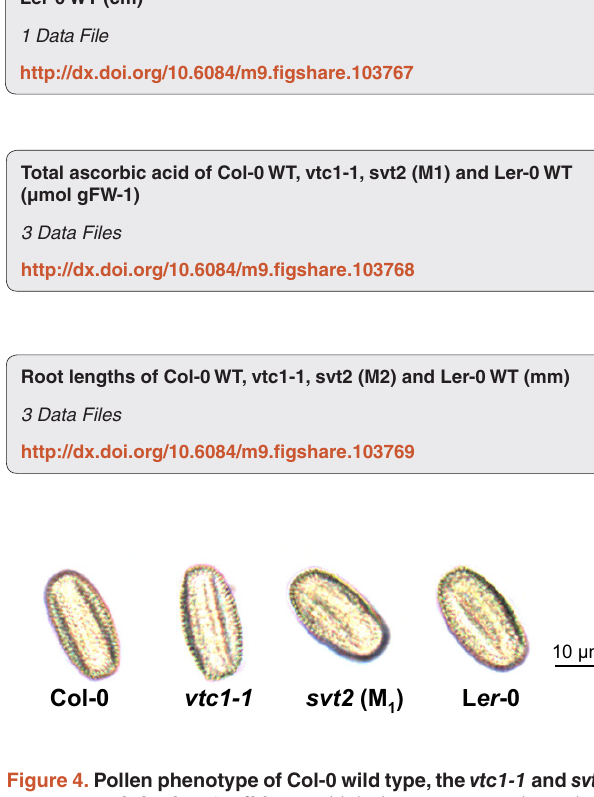
Figure 4. Pollen phenotype of Col-0 wild type, the vtc1-1 and svt2 mutants and the L er -0 wild type. Light images were taken when plants were 4.5 weeks old. Scale bar represents 10 µm.